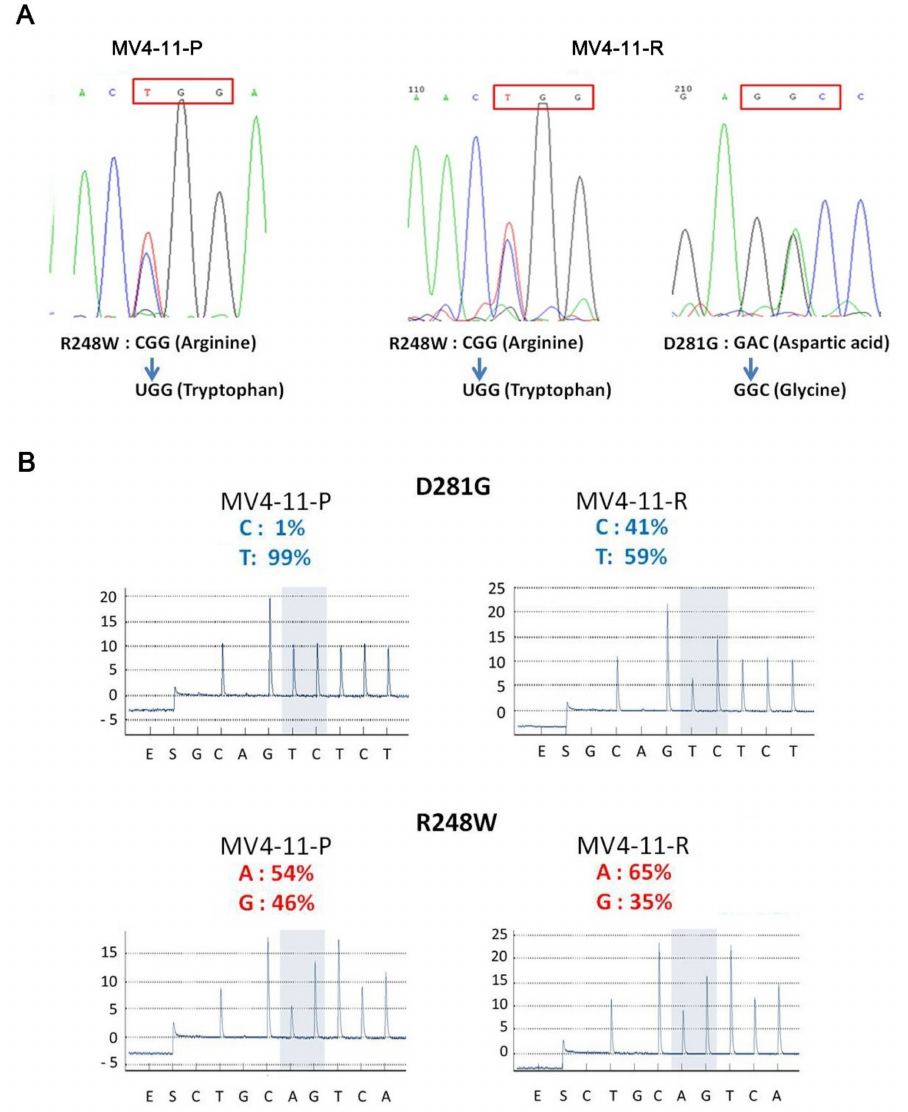
Figure 5. Sequencing analyses of the TP53 gene reveal the emergence of a new TP53 mutation, D281G, in MV4-11-R. ( A ) The R248W (CGG → TGG, red frame) TP53 mutation was detected in MV4-11-P, while both R248W and D281G (GAC → GGC, red frame) mutations were observed in MV4-11-R using Sanger sequencing analysis. ( B ) The percentage of mutant antisense-alleles for D281G and R248W mutations in MV4-11-P and MV4-11-R was determined by